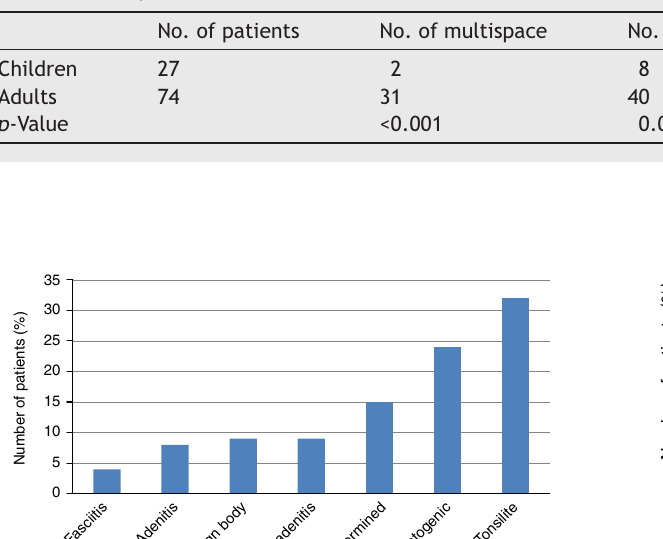
Comparison of children and adults.